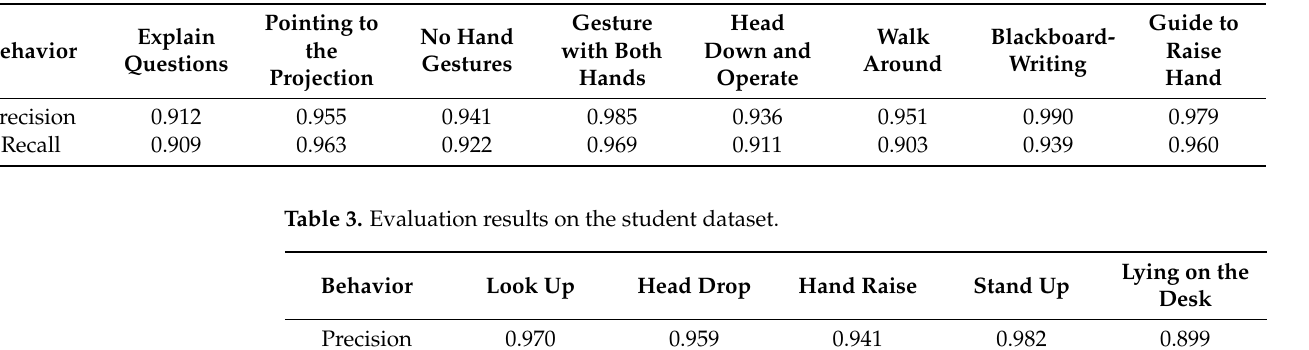
Table 2. Evaluation results on the teacher dataset.